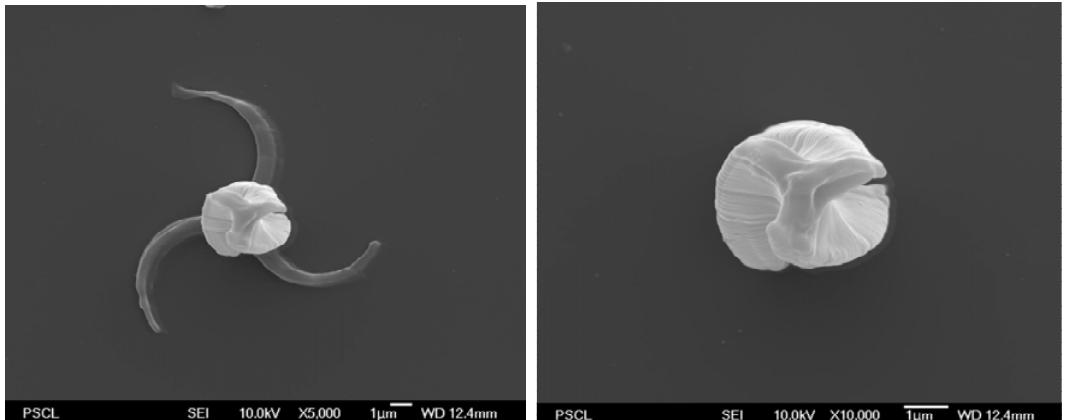
Figure 3. The SEM figures (top-view) of the Archimedes screw-based micromachines ( left ) and Archimedes-screws ( right